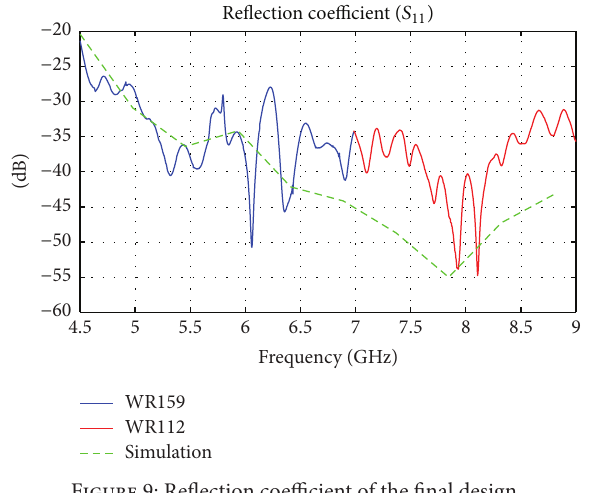
Figure 9: Reflection coefficient of the final design.